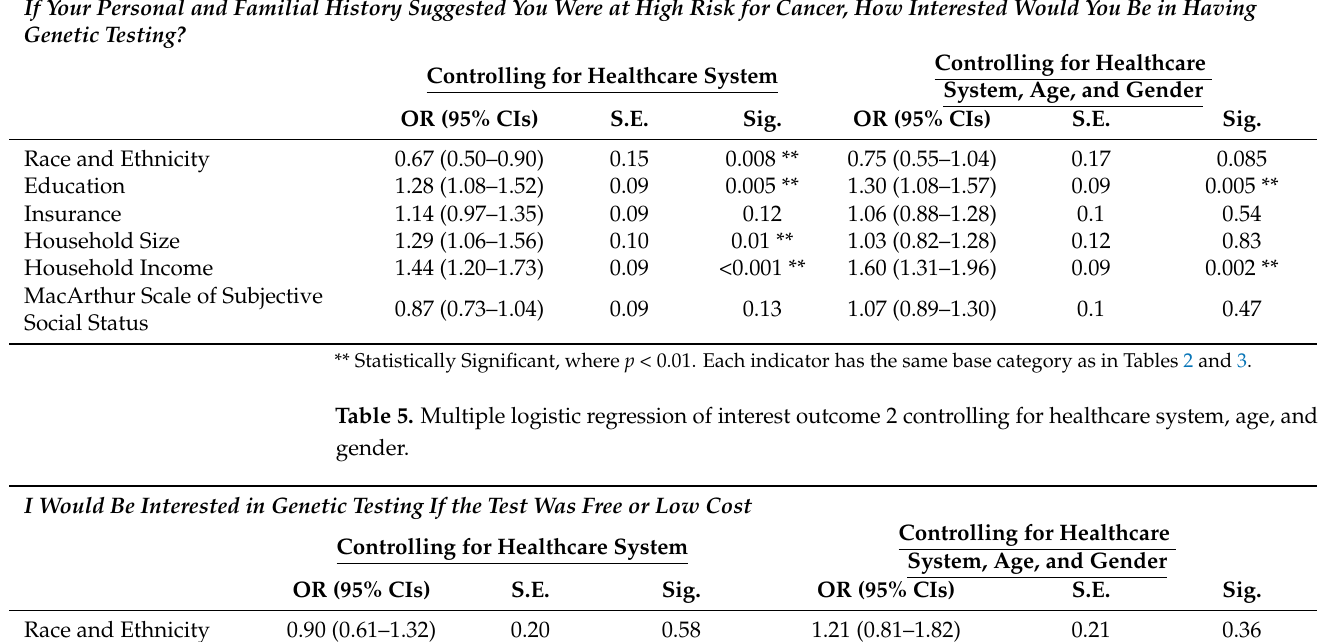
Table 4. Multiple logistic regression of interest outcome 1 controlling for healthcare system, age, and gender.